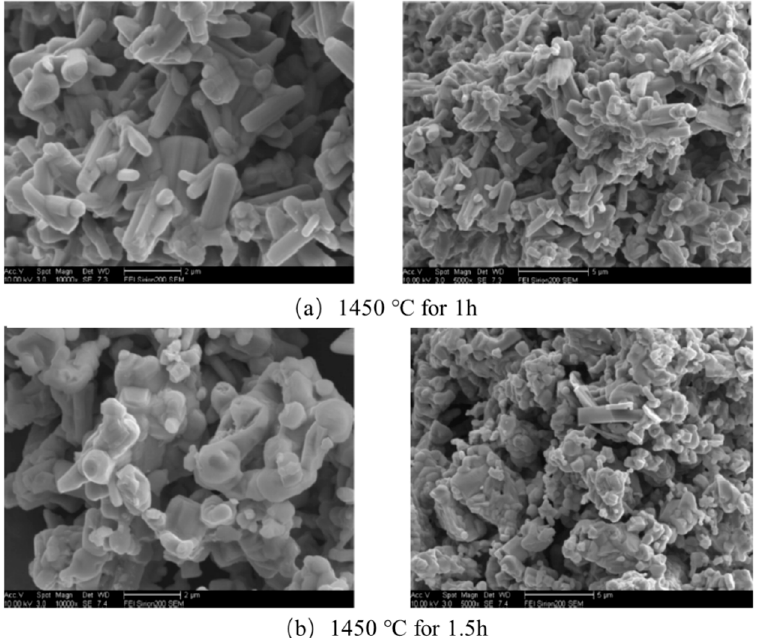
Figure 6. FESEM images of ZrB 2 powders synthesized at 1450 °C for different holding times (( a ) 1 h; ( b ) 1.5 h) [66].